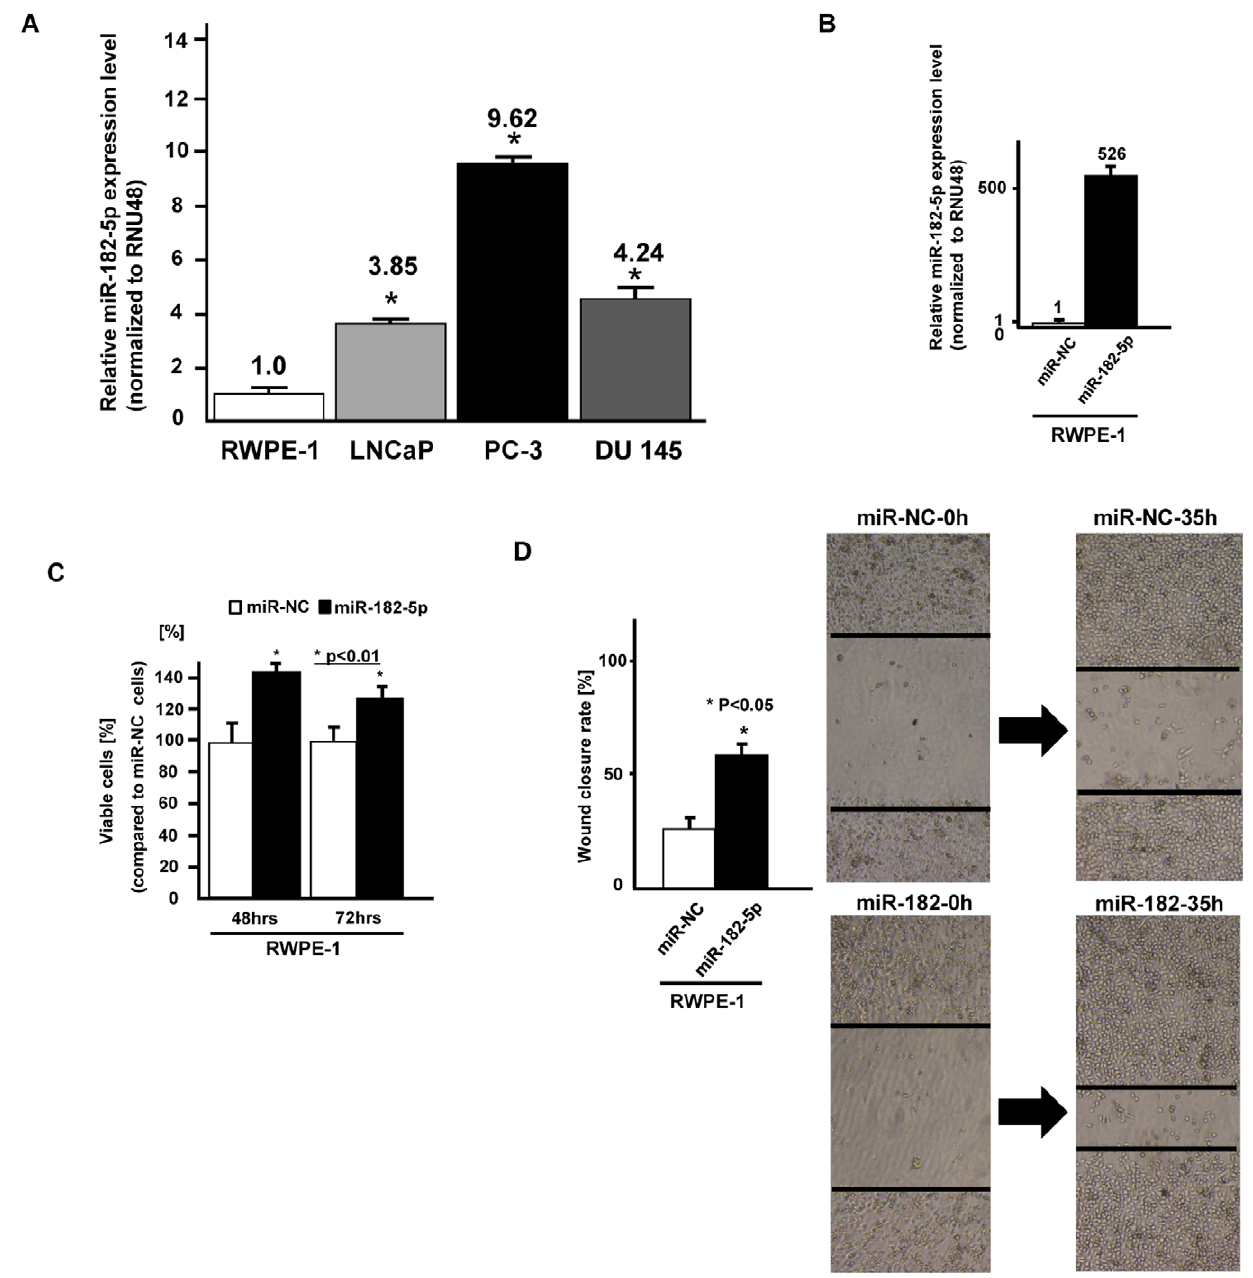
Figure 2. Expression of miR-182-5p in cell lines and effect of miR-182-5p overexpression on normal prostate cells (RWPE-1). A. The expression of miR-182-5p was significantly higher in three prostate cancer cell lines compared to a normal prostate cell line (RWPE-1), B. Relative miR- 182-5p expression (miR-NC or miR-182-5p precursor transfected RWPE-1 cells), B. cell viability assay (miR-NC or miR-182-5p precursor transfected RWPE-1 cells), C. Wound healing assay (miR-NC or miR-182-5p precursor transfected RWPE-1 cells). Error bars represent 6 S.D. (standard deviation). doi:10.1371/journal.pone.0055502.g002 ( Fig. 3-A ). Cell viability (MTS assay), migration and invasion assays were performed ( Fig. 3-B, 3-C, 3-D ) and we observed a significant decrease in cell proliferation ( Fig. 3-B ), invasion We used two prostate cancer cell lines (PC-3 and DU145) with ( Fig. 3-C ) and migration ( Fig. 3-D ) in miRNA-182-5p knock- high miR-182-5p expression for further experiments since the down PC-3 and DU-145 cells compared to inhibitor-NC miR-182-5p expression was significantly higher in these cell lines. transfected cells. At 48 hours after transfection of inhibitor-NC or miR-182-5p inhibitor into PC-3 and DU145 cells, the miR-182-5p knock-down was verified by real time RT-PCR (0.003, 0.034, respectively)